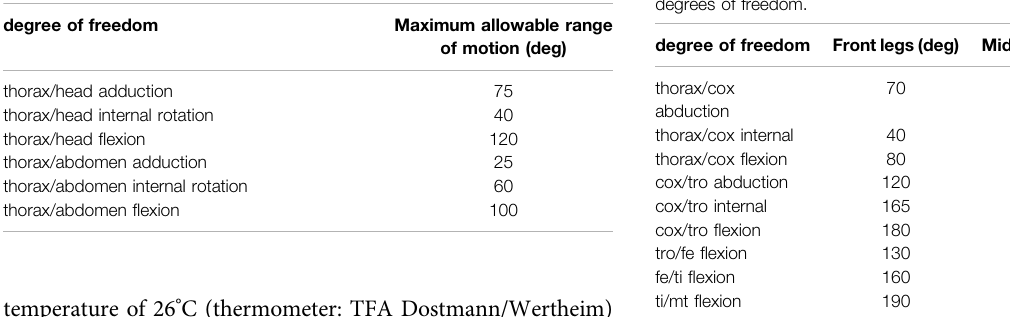
TABLE 1 | Maximum range of motion allowable for each degree of freedom of trunk joints. Values are presented per leg: front, middle, and rear. The same valueswereusedforleftandrightlegs.ThesevaluesweredeterminedinOpenSim by articulating each degree of freedom of the model until some structures of the joint segments touch each